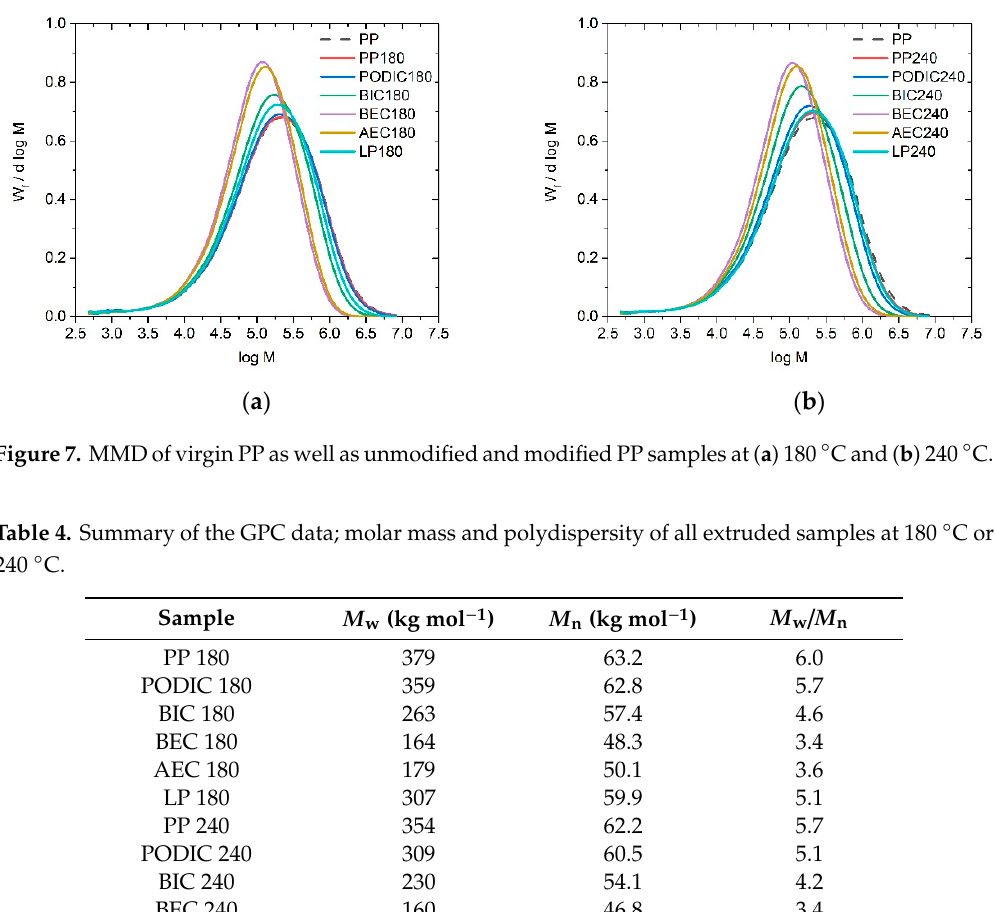
( b ) Figure 6. tan δ of the unmodified and modified PP with extrusion temperature of ( a ) 180 °C and ( b ) 240 °C; measured at 230 °C. 3.3. Molar Mass Determination In addition to determining the MMD using dynamic rheology, high-temperature gel permeation chromatography (HT-GPC) measurements were performed. GPC is one of the most important methods to determine the MMD of polymers [63]. GPC measurement, a well-established concept in the literature, provides a further possibility to determine the molecular structure and any modifications made to polymers [51,64–68]. The corresponding curves of the GPC measurements are illustrated in Figure 7. The MMD of the virgin PP (without extrusion) was used for both cases as reference (dashed lines). In Figure 7a, the curves present nearly the same behavior compared to those of the reference PP and the unmodified PP. Only AEC and BEC show a significant change in MMD curves. The distribution becomes